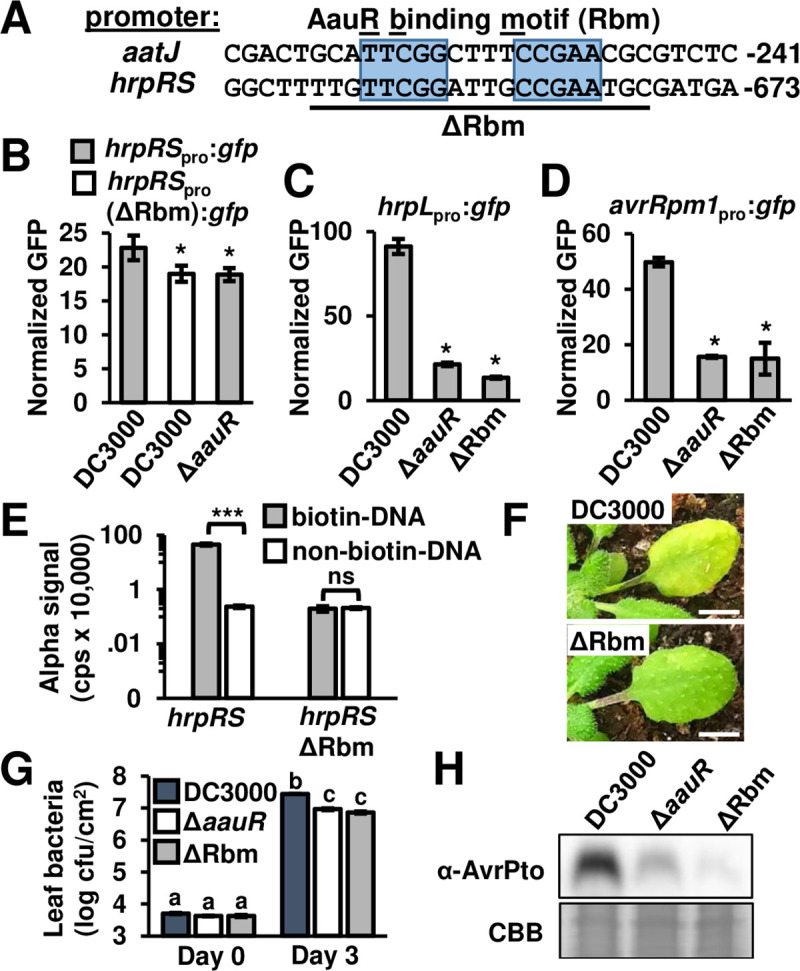
An AauR binding motif within the hrpRS promoter is required for T3SS deployment and maximal virulence of DC3000 in Arabidopsis.(A) Alignment of DC3000 aatJ and hrpRS promoter regions containing the AauR-binding motif (Rbm). Conserved palindromic repeats are highlighted in blue. Numbers are distances in base pairs of each Rbm from predicted translation start sites for each gene. The 20 bp region deleted in ΔRbm strain is underlined. (B-D) GFP fluorescence from bacteria cultured in minimal medium with 10 mM fructose and 200 uM aspartate for 6 hours. Graphed are means ± SE of GFP fluorescence normalized to OD600 and background fluorescence from empty vector strains; n = 3. (B) DC3000 carrying a hrpRSpromoter:gfp reporter or hrpRSpromoter(ΔRbm):gfp reporter lacking the predicted Rbm. A ΔaauR strain carrying hrpRSpromoter:gfp was included for comparison. (C) DC3000, ΔaauR and ΔRbm strains each carrying a hrpLpromoter:gfp reporter. (D) DC3000, ΔaauR and ΔRbm strains each carrying an avrRpm1promoter:gfp reporter. Asterisks in B-D denote significant difference between strains based on t-test, P < 0.05. (E) AlphaScreen assay of recombinant AauR protein binding to hrpRS promoter DNA with or without Rbm. Graphed are means ± SE of luminescence from assay wells, n = 4. Asterisks indicate P < 0.001 based on t-test, ns is not significant at α = 0.05. (F-H) 1 x 106 cfu/mL of DC3000 or ΔRbm were syringe-infiltrated into Arabidopsis leaves. (F) Photographs of disease symptoms taken 3 days post-infection. White bar is 0.5 cm. (G) Leaf bacteria populations enumerated on day 0 and day 3 by serial dilution plating of leaf extracts. Graphed are log-transformed means ± SE of bacteria colonies isolated from infected tissue, n = 3 for day 0 and n = 3 for day 3. Small-case letters denote significance groupings based on pairwise t-tests, P < 0.001. (H) AvrPto levels in Arabidopsis leaves syringe-infiltrated with 5 x 108 cfu/mL of DC3000 or ΔRbm. Upper panel is immunoblot detection of AvrPto in infected leaf tissue 6 hours post-infiltration. Lower panel is Coomassie Brilliant Blue (CB) staining of blot as a loading control. Results in panels B-H are representative of 3 independent experiments.